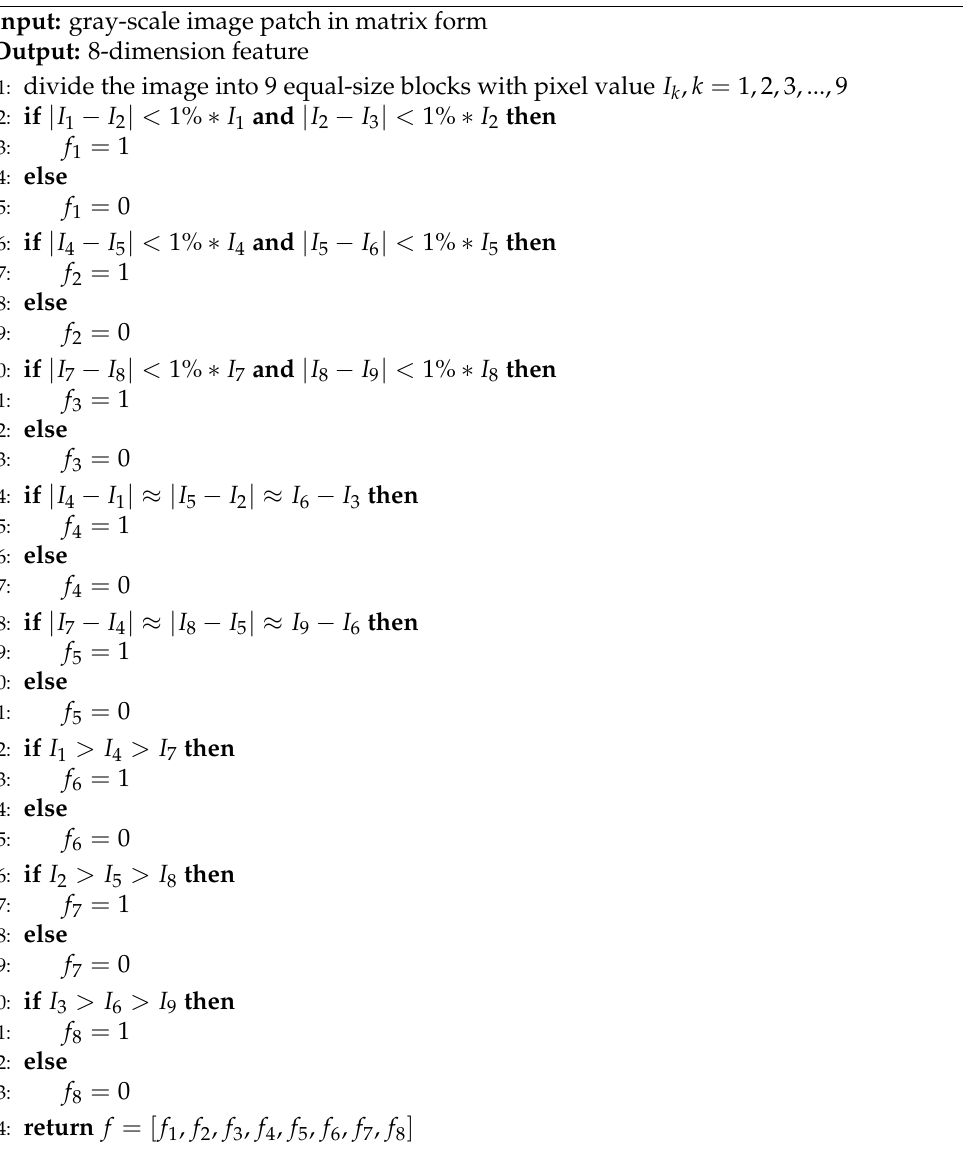
Algorithm 1 Improvd LBP